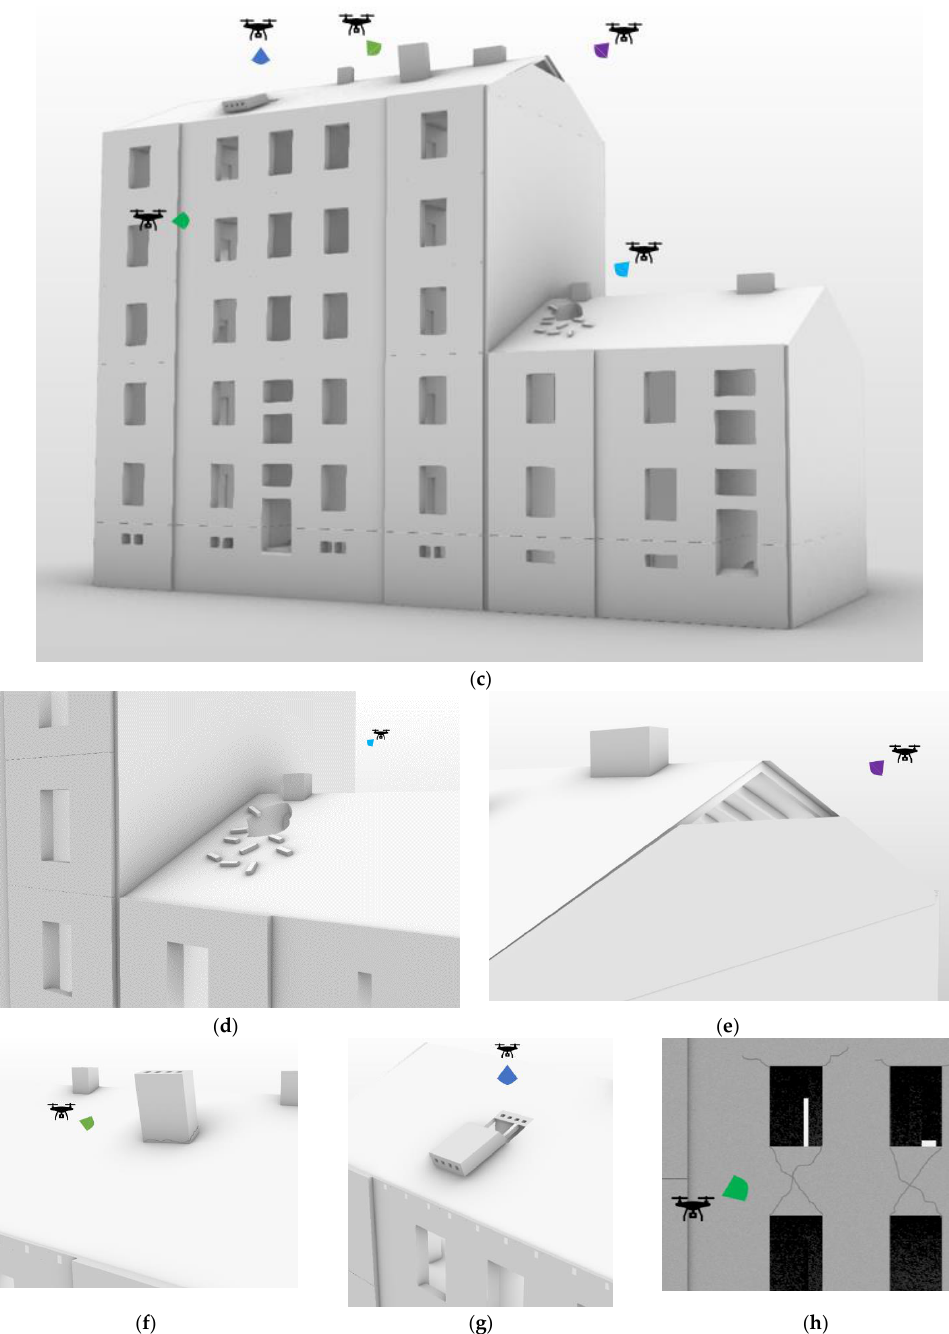
Figure 1. Photogrammetric multi-sensor systems on UAVs enable a fast and accurate collection of large amounts of spatial data for building damage detection and mapping. ( a ) Undamaged building, ( b ) visual inspection from street level, ( c ) post-earthquake assessment with UAV systems, ( d – h ) possible damages on a building after an earthquake.